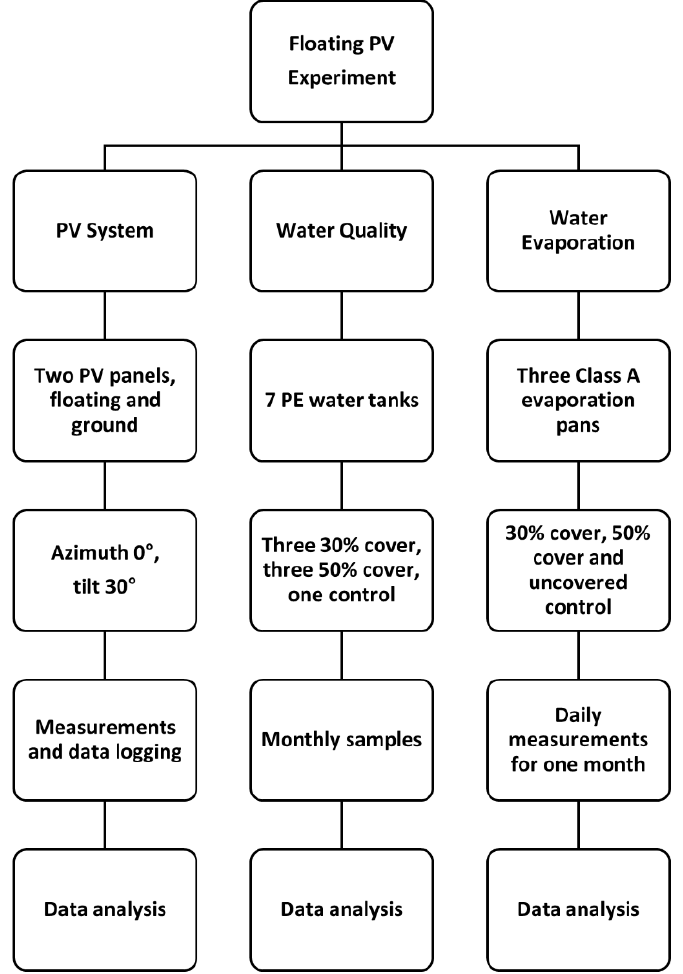
Figure 1. Flowchart of experiment methodology.